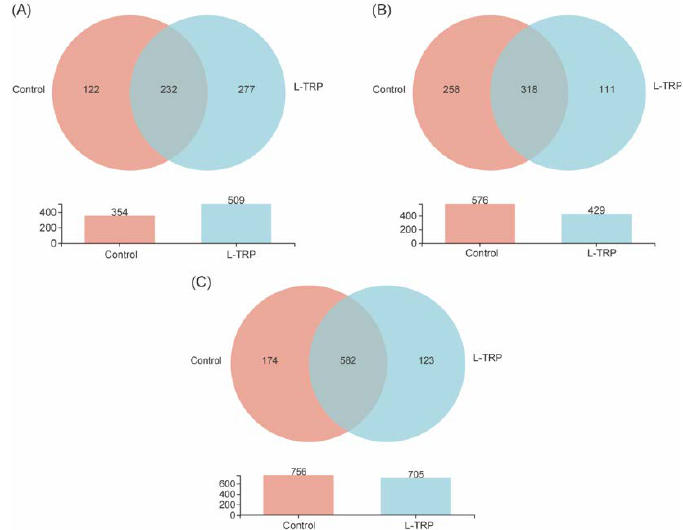
Figure 3. Venn diagram of the unique and shared operational taxonomic units (OTUs) in the control group and the L-TRP group in August ( A ), September ( B ) and November ( C ). The number indicates the related OTU in each group of the total sequence.